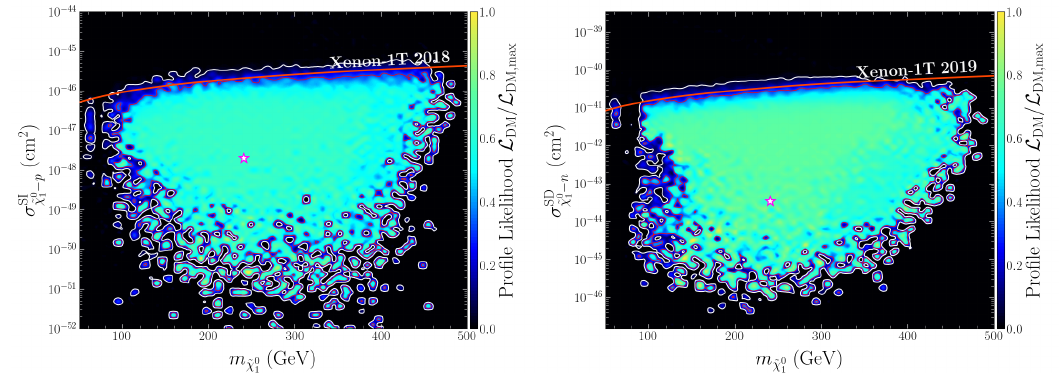
Figure 3 . Same as figure 1, but for h ≡ h 2 scenario.